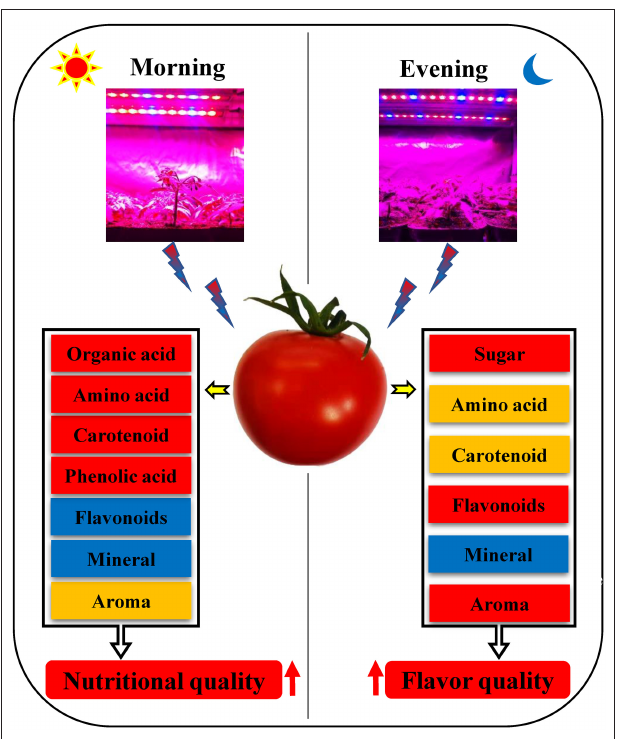
FIGURE 8 | Effects of LED supplementation on fruit quality of tomato in the morning and evening. Red represents an increase in the substance content, orange also represents an increase in the substance content, but the increase is weaker than the red box, and blue represents a decrease in the substance